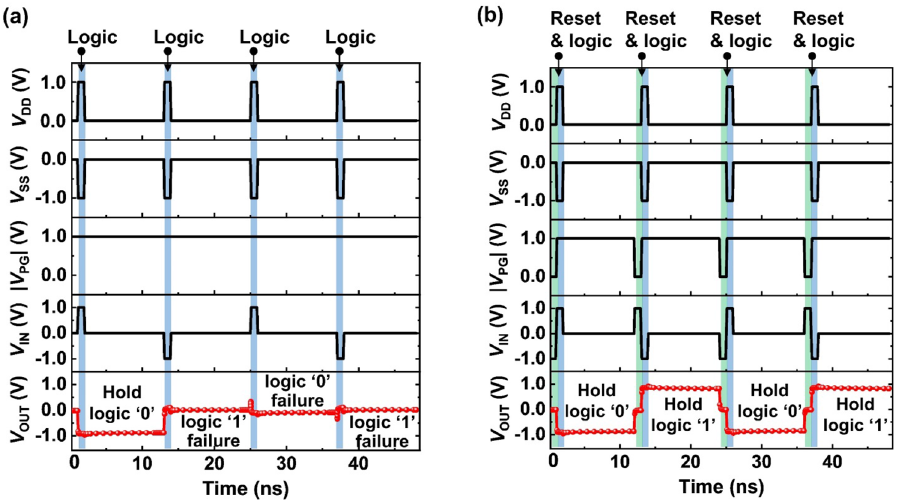
Figure 4. ( a ) Timing diagrams of consecutive logic and hold operations: hold logical data failure. ( b ) Timing diagrams of consecutive reset, logic and hold operations. The pulses of the drain, source, program-gate, input, and output voltages ( V DD , V SS , V PG , V IN , and V OUT ) are applied with a logic (reset) pulse width of 1 ns and a hold pulse width of 10 ns.